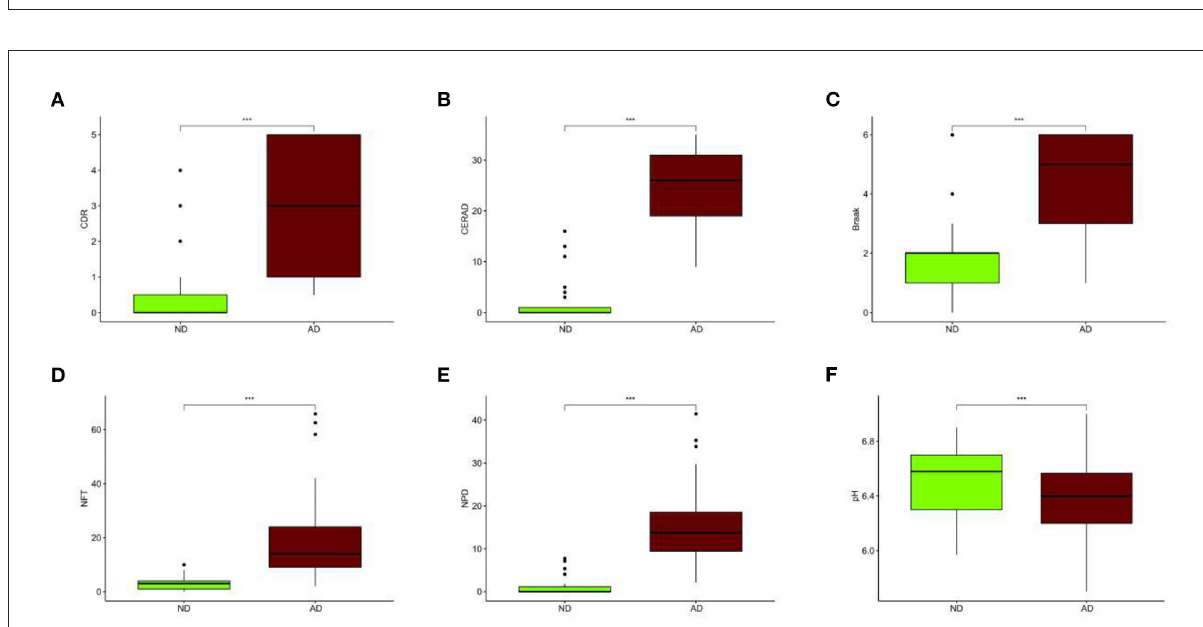
FIGURE3 Different clinical characteristics between AD and ND. (A) Different CDR between AD and ND. (B) Different CERAD between AD and ND. (C) Different Braak between AD and ND. (D) Different NFT between AD and ND. (E) Different NPD between AD and ND. (F) Different pH between AD and ND. ND, n = 456–489; AD, n = 690–739. vs. ND, Wilcoxon’s rank-sum test. *** P <